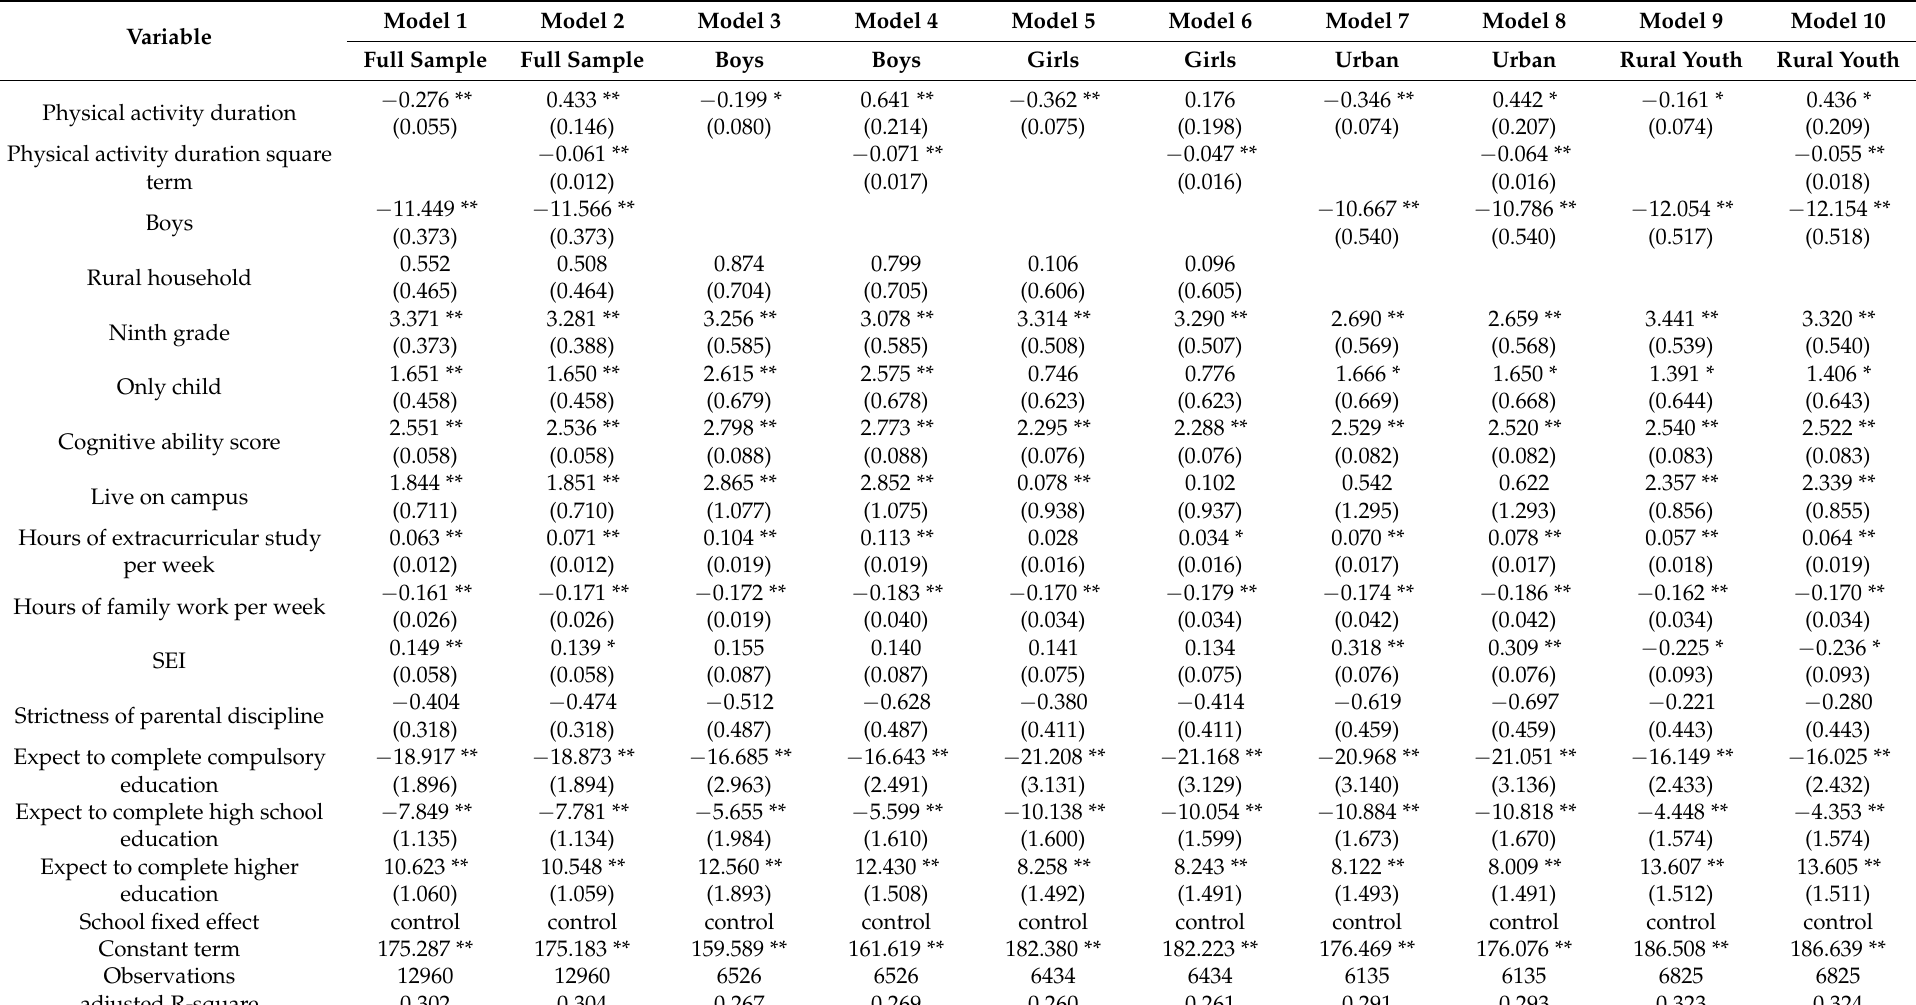
Table 2. Baseline regression of academic achievement and heterogeneity test estimation